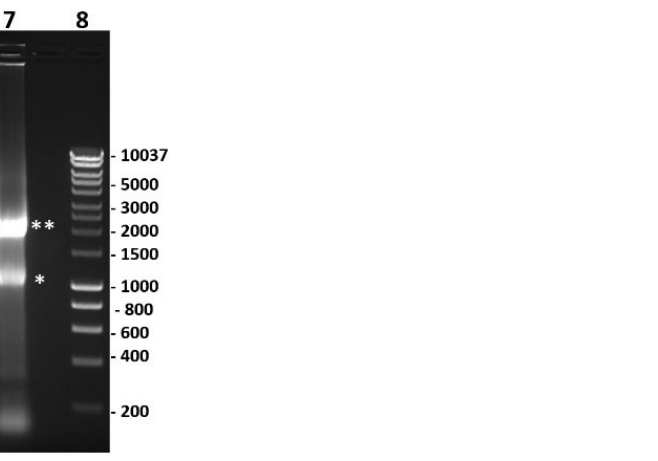
Figure 15. Ribosomal RNA profile of A549 cells infected with wild-type and recombinant vaccinia viruses at 24 h post-infection. Lanes 1 and 8: DNA size marker. Lanes 2 and 7: non-infected A549 cells. Lane 3: wild-type VVC. Lane 4: VV-VP1080-E3L. Lane 5: the Δ E3L virus VV-VP1080. Lane 6: VV-VP1080-NS5BTV1. The positions of 28S rRNA and 18S rRNA are indicated with double and single asterisks, respectively. Lane 5, where cells were infected with the Δ E3L virus VV-VP1080, shows extensive degradation of both 28S and 18S rRNA, although adding back the E3L or NS5 gene into VV-VP1080 (VV-VP1080-E3L or VV-VP1080-NS5BTV1) protected rRNA from degradation.